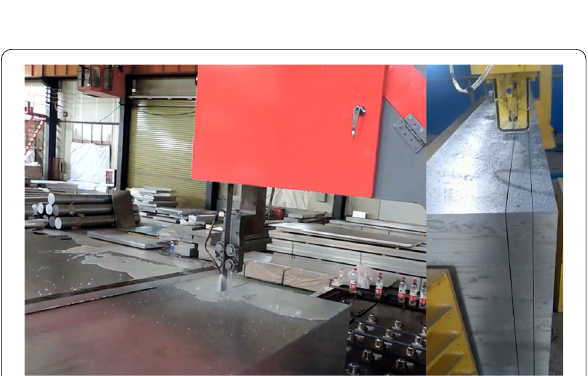
Figure 5 Cutting super sized aviation aluminium